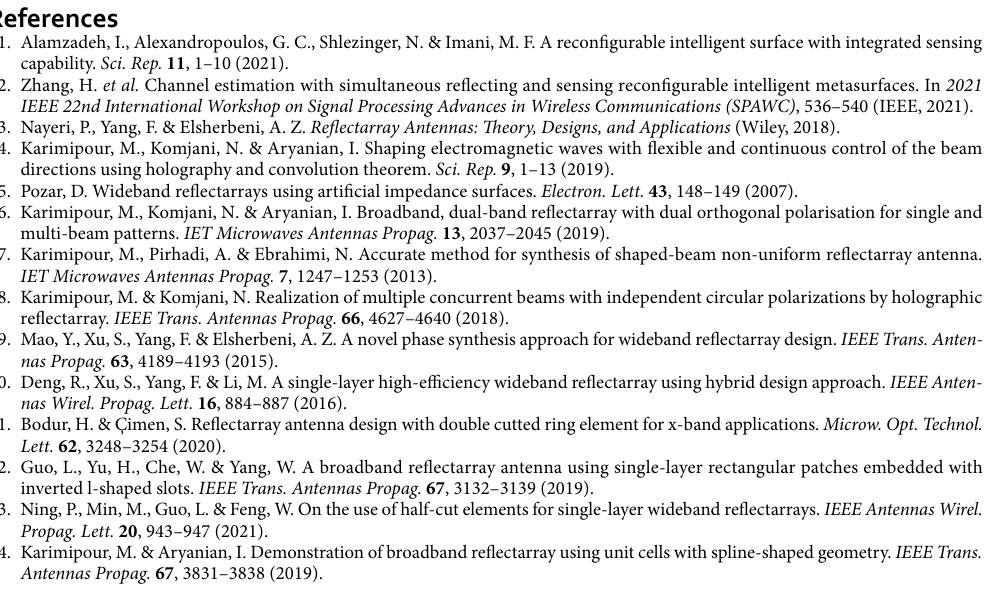
Table 2. The comparison between this work and previous works. The asterisk ( ∗ ) in the bandwidth row denotes the 4-dB bandwidth. Other references report 1-dB gain bandwidth. In addition, TDFE stands for two degrees of freedom elements, and superscripts † and †† denote the initial and end frequencies of the band. ’NR’ stands for the not-reported data.